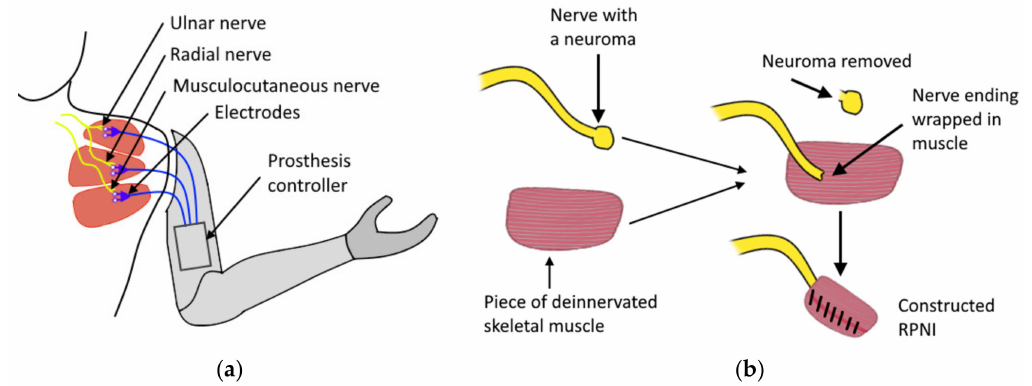
Figure 1. Surgical procedures for improving the control over a prosthesis: ( a ) TMR—reinnervated muscles might be used for prosthesis control after proximal amputation [10]; ( b ) illustration of RPNI construction